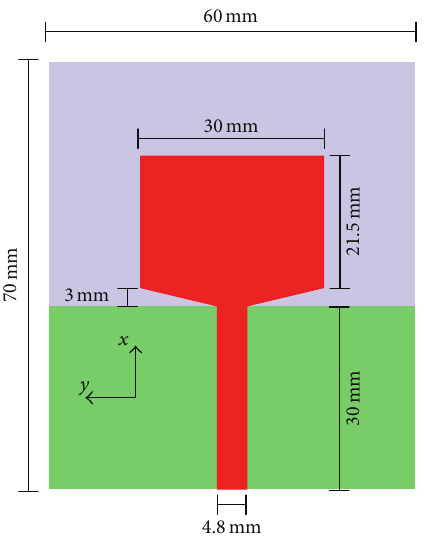
Figure 2: The broadband printed antenna.